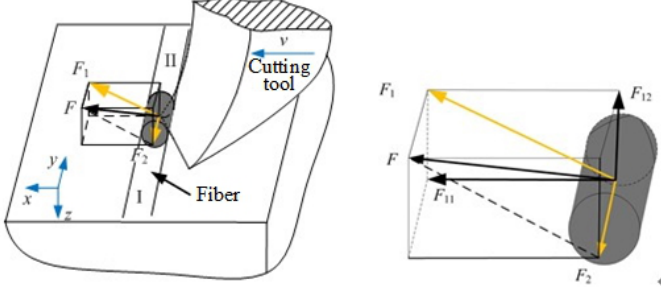
Figure 14. Force analysis of a single fiber during the cutting process when the fiber orientation angle is 45 ◦